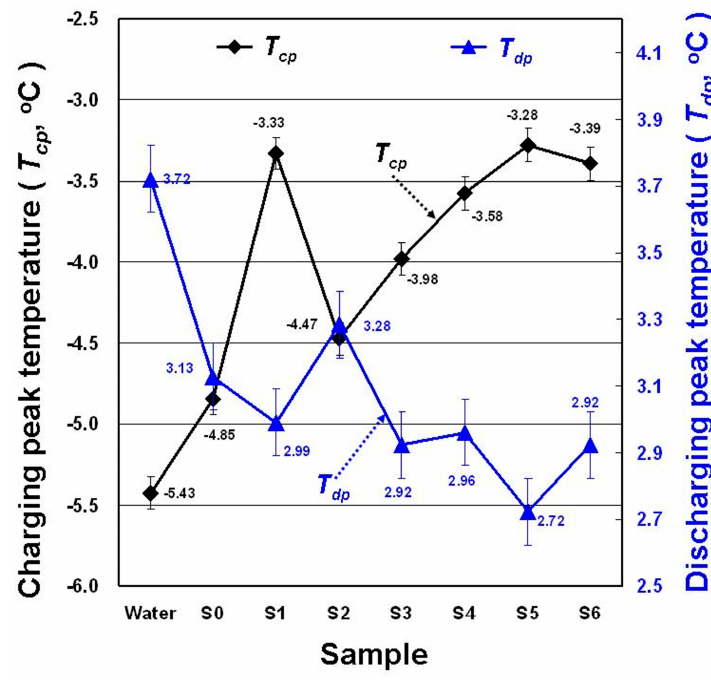
Figure 7. Changes in solidification temperature ( T cp ) and melting temperature ( T dp ) for the samples.